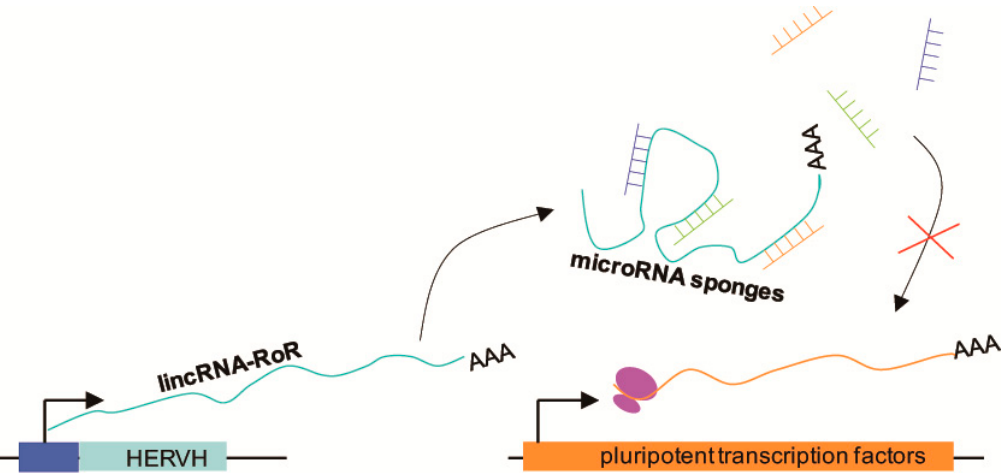
Figure 2. Schematic illustration showing how pluripotent transcription factors are protected from miRNA-mediated degradation. LincRNA-RoR, a long intergenic noncoding RNA, is transcribed from human endogenous retrovirus subfamily H (HERVH), and then acts as an miRNA sponge to prevent miRNA-mediated degradation of pluripotent transcription factor mRNAs. The intact pluripotent transcription factor mRNAs can then be